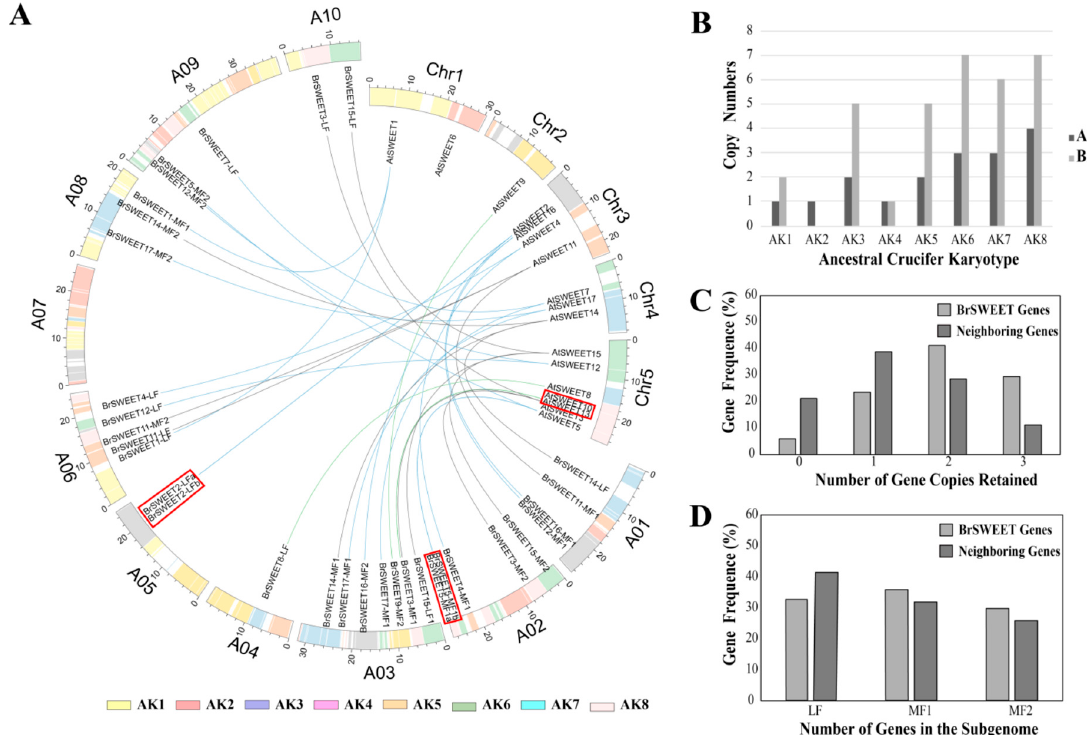
Figure 2. Basic information of the SWEET genes in the Arabidopsis thaliana and Brassica rapa genome. ( A ) Assignment of the SWEET genes to the chromosomes and 24 gene blocks (GBs) of thaliana and B. rapa ; ( B ) SWEETs numbers on the inferred ancestral crucifer karyotype; ( C ) gene frequencies of retained homologous copies in the syntenic region; and ( D ) three sub-genomes with SWEETs in B. rapa . The red box labeled gene pairs in ( A ) expanded by tandem duplication and the fractionation of SWEETs homologs in different sub-genome are listed in Table S3. Different colored lines indicate the orthologous SWEETs (green for single copy, blue for two copies, and black for three copies) between A. thaliana and B. rapa .